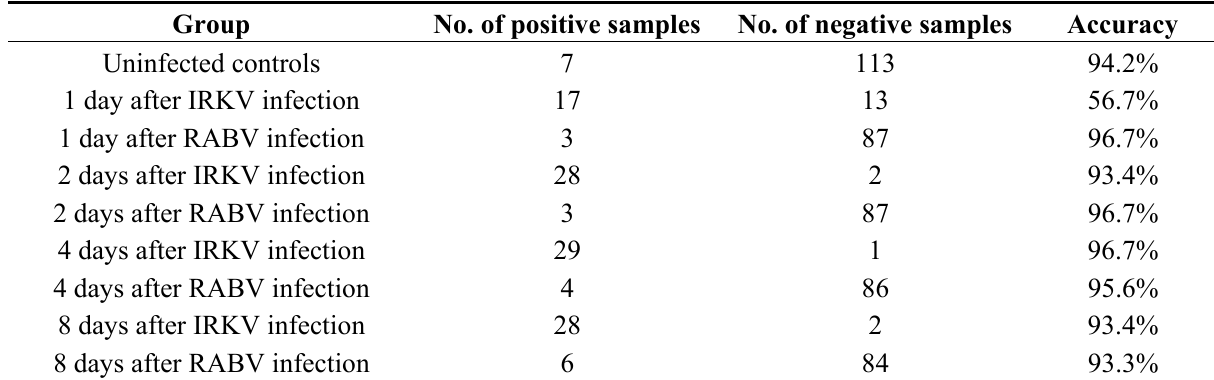
Table 1. Detection of IRKV infection using serum peptide